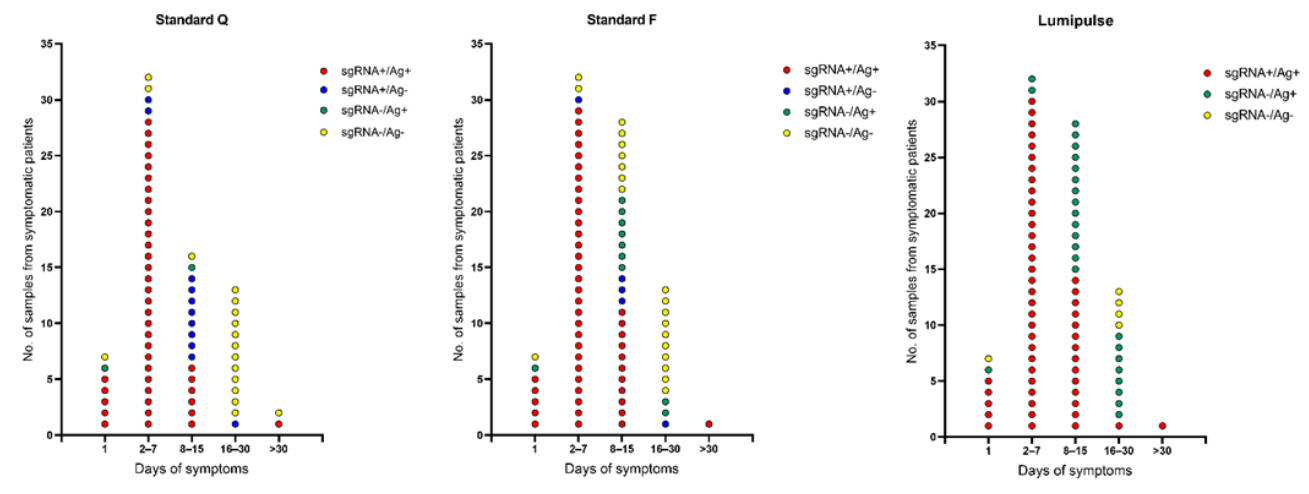
Figure 1. Distribution of gRNA or sgRNA reverse transcription-PCR Ct values for NPS samples from 102 COVID-19 patients tested for antigen detection with Standard Q, Standard F, or Lumipulse. Colors indicate groups of results stratified as sgRNA positive/Ag positive (red), sgRNA positive/Ag negative (blue), sgRNA negative/Ag positive (green), or sgRNA negative/Ag negative (yellow). Ag, antigen; Ct, cycle threshold; COVID-19, coronavirus disease 2019; gRNA, genomic RNA; NPS, nasopharyngeal swab; sgRNA, subgenomic RNA.